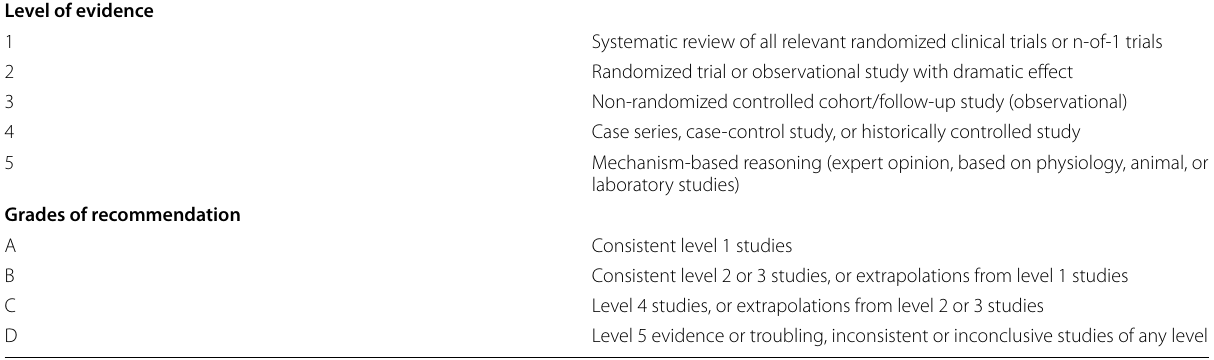
Table 2 Levels of evidence according to Oxford Centre for Evidence‑Based Medicine (OCEBM) [12] Level of